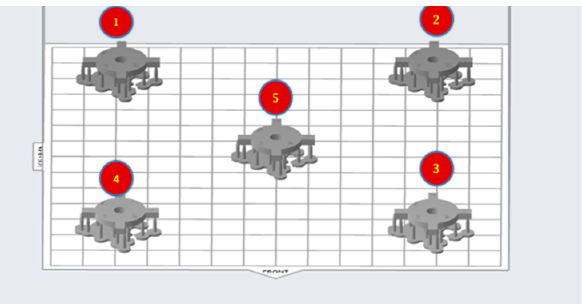
Figure 2. The layout of the designed coupons on the build platform of the 3D printing software (PreForm software, Formlabs, Somerville, MA, USA). Numbers were added using Microsoft PowerPoint software (Microsoft Corporation, Redmond, WA, USA).